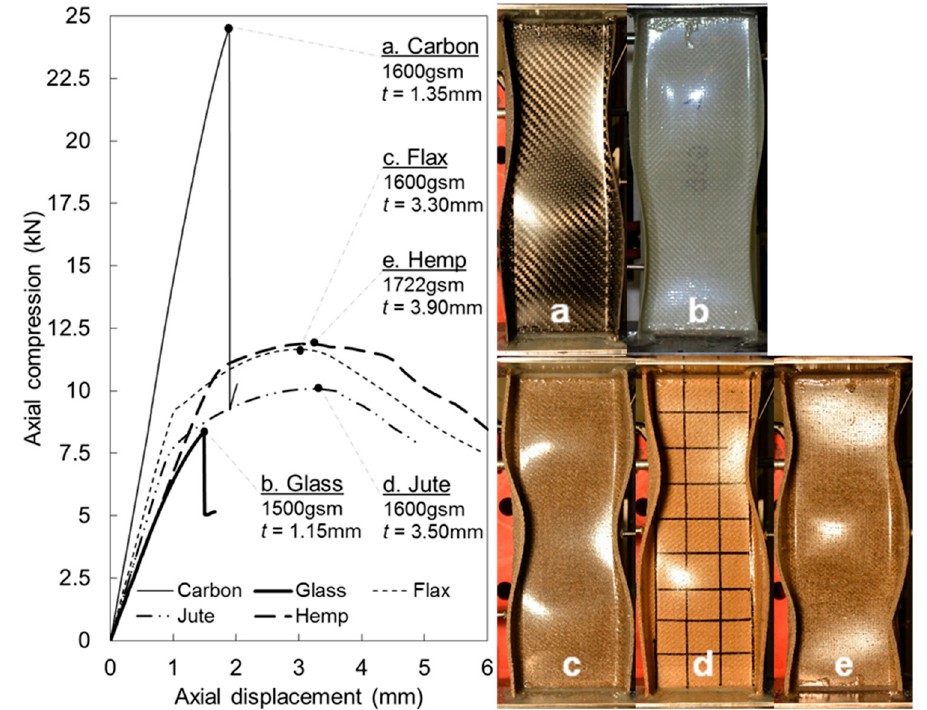
Figure 7. Exemplar composite channel compression tests for the approximately 1600 gsm total fiber areal mass comparator group (1500–1722 gsm) (all column heights are 300 mm).